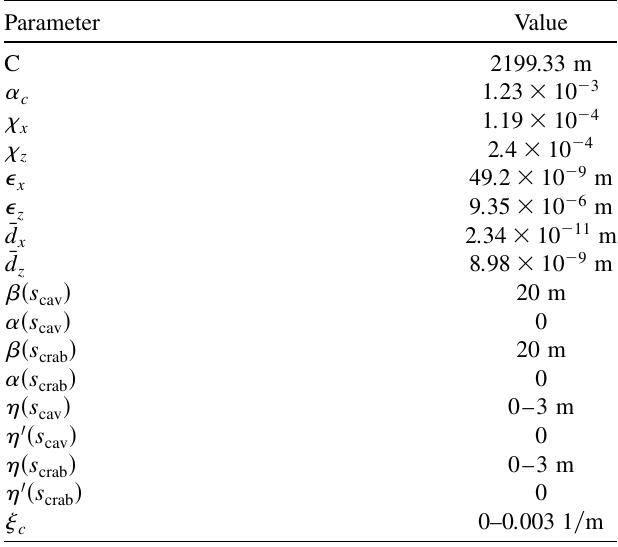
TABLE VI. Parameters used in our numerical examples based on the PEP-II Low Energy Storage